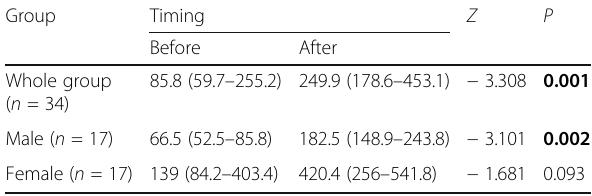
Table 4 ATX before and after DAAs treatment: it showed a Table 6 APRI and FIB4 scores before and after treatment: it statistically significant higher ATX after treatment with DAAs as showed a statistically significant improvement in APRI score (but a whole. By stratifying the cases according to sex, this statistical not FIB4 score) after treatment with DAAs significance exists only in male patients but not female patients Score Before After Group Timing Z P Before After